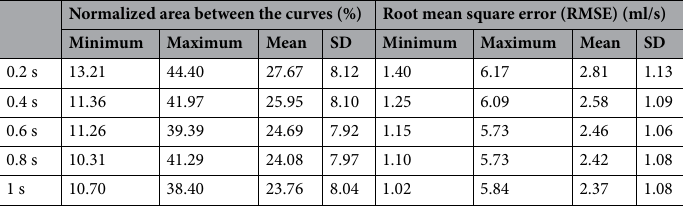
Normalized area between the curves (%) Root mean square error (RMSE)